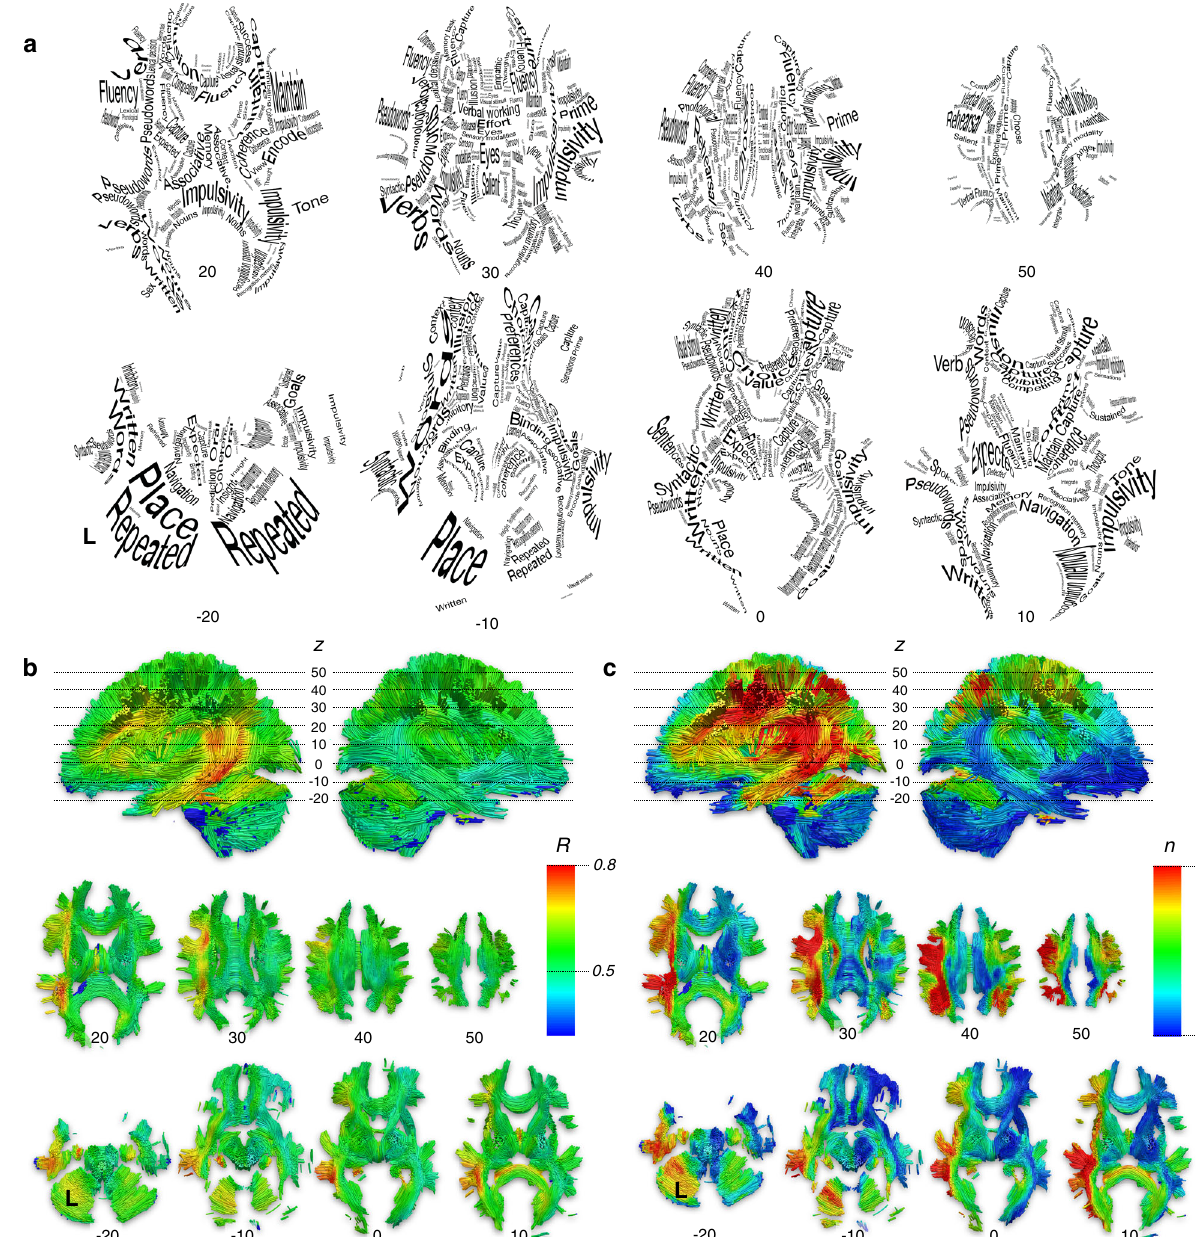
Fig. 4 Atlas of white matter function. a summary map of the white matter function only displaying terms with the highest statistical level (see Supplementary Figs. 50 – 57 for high resolution). b Effect size related to the prediction of white matter function. R > 0.5 indicates a large effect size. c Versatility maps. For each voxel of the MNI, the value indicates the number of terms related to the prediction of white matter function with a large effect size. The atlas white matter function was replicated a second time. The atlas of white matter function was replicated a second time and indicated a good reproducibility (average Pearson R = 0.885±